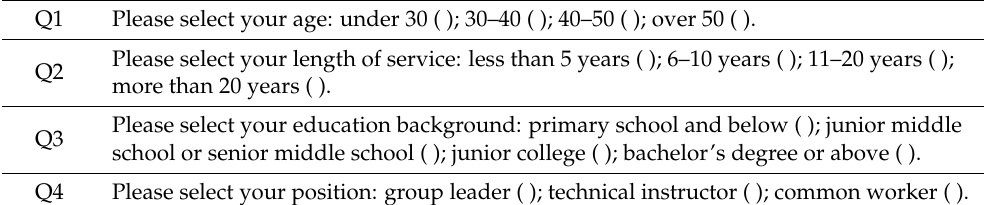
Table 1. Questions to investigate the basic characteristics of the